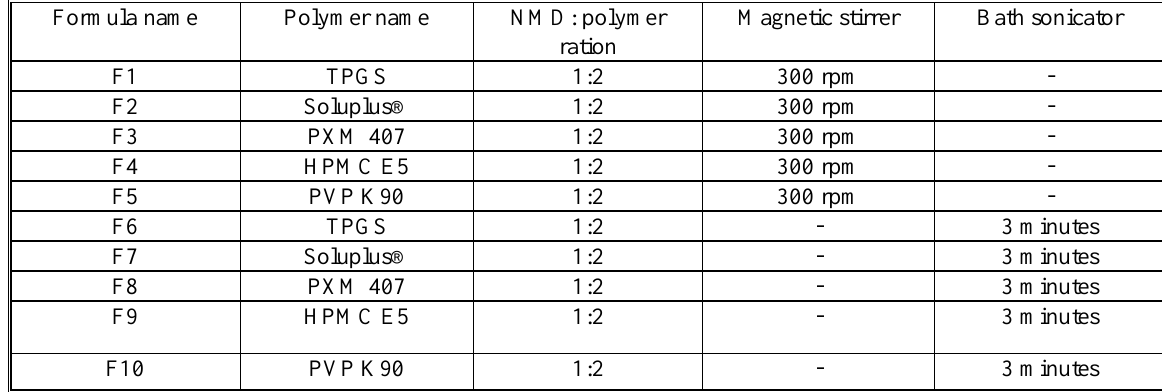
Table 1.The Composition of The prepared NMD